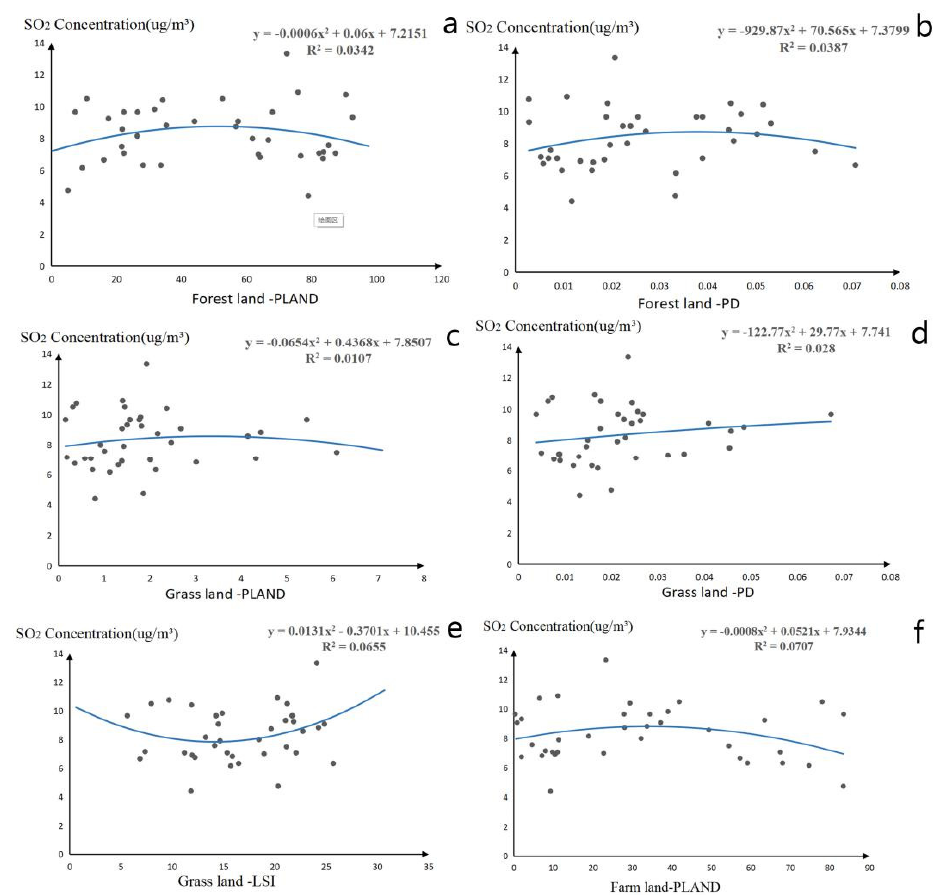
Figure 3. Threshold of significant landscape pattern indices for SO 2 pollutant (( a – f ) represents the threshold effect of SO 2 and forest land PLAND, forest land PD, grassland PLAND, grassland PD, grassland LSI, and farmland PLAND landscape pattern index).